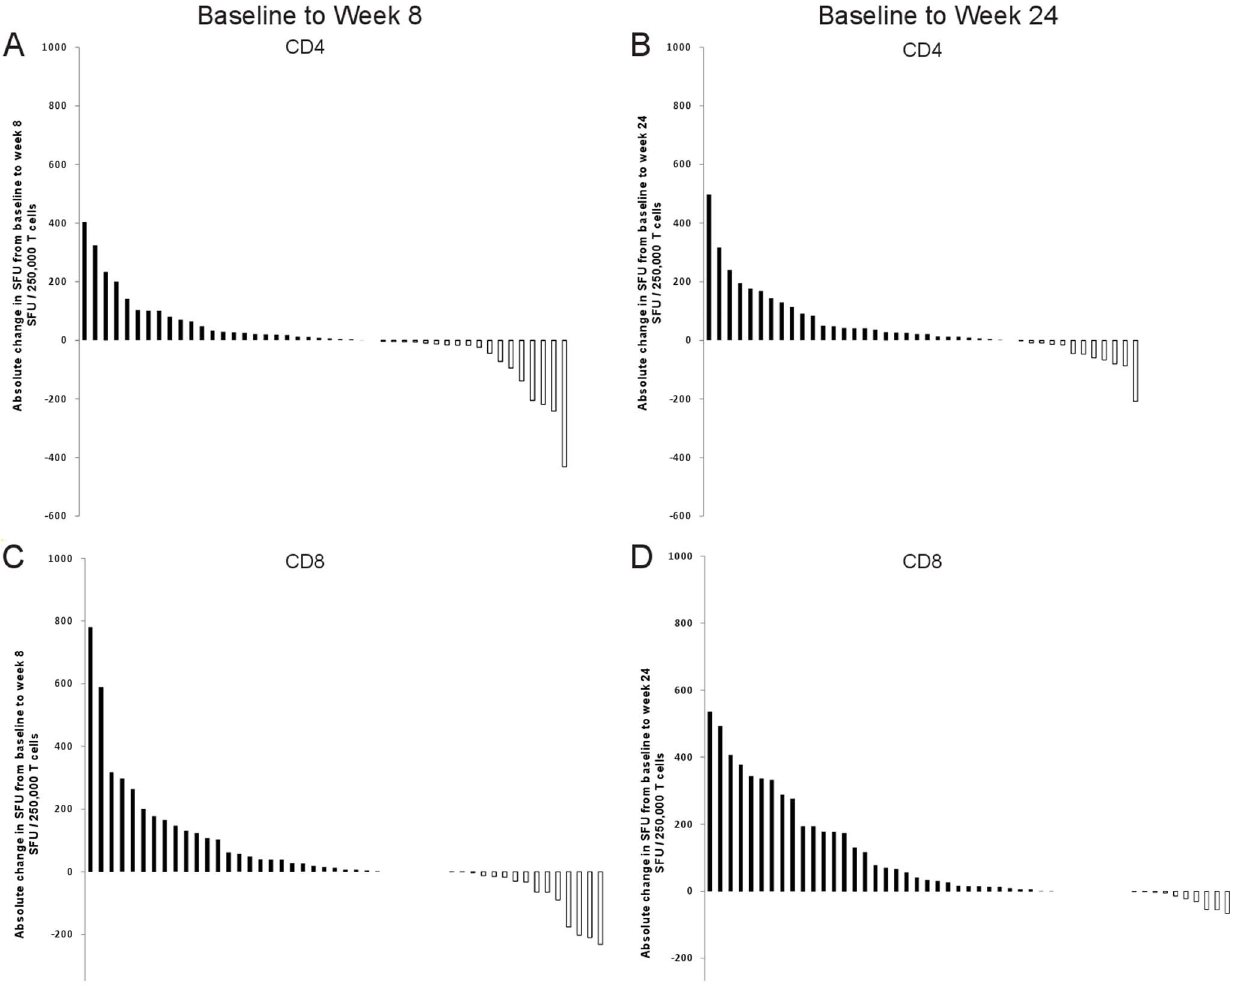
Figure 2. Individual profiles of the absolute change in the Mtb specific T cell responses (spot forming units; SFU) from baseline to week 8 and baseline to week 24 in smear and culture positive, HIV negative, pulmonary TB patients during antituberculosis therapy. The waterfall plots show the absolute change in magnitude (SFU) between the baseline time point to week 8 for the Mtb specific CD4 + (A) and CD8 + (C) T cell response. The absolute change in magnitude for the baseline time point to week 24 is shown for the Mtb specific CD4 + (B) and CD8 + (D) T cell response. Black bars represent SFU decreasing from baseline to the respective time point, whereas white bars represent increasing SFU from baseline to the respective time